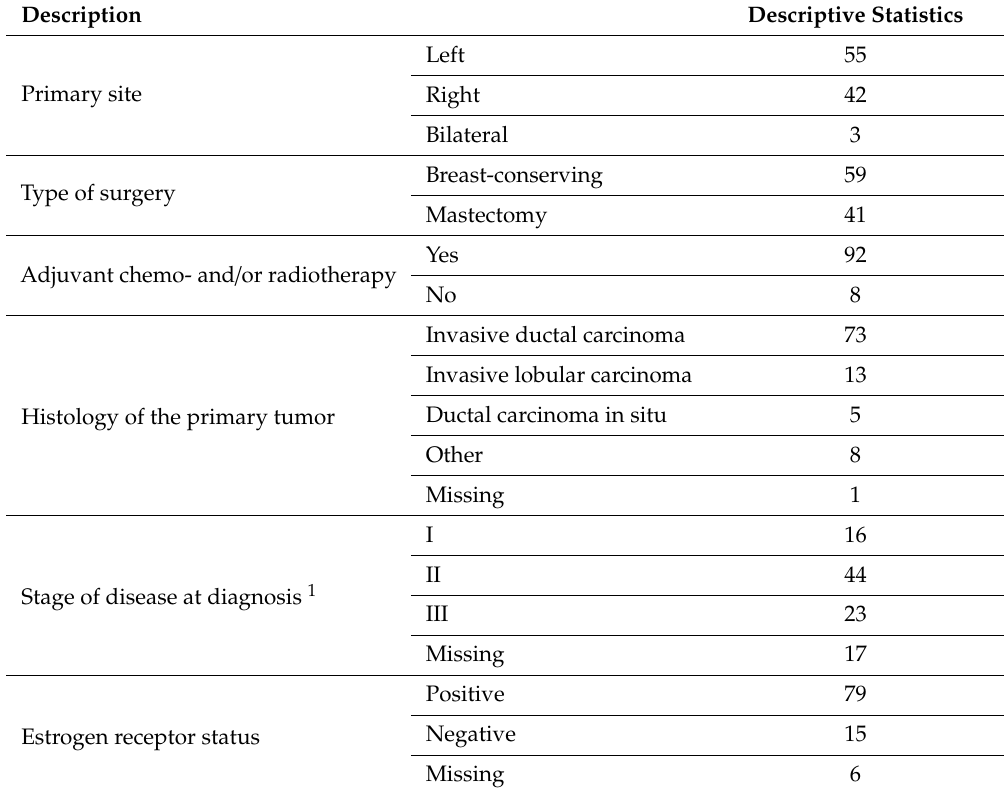
Table 1. Characteristics of 100 Danish patients with breast